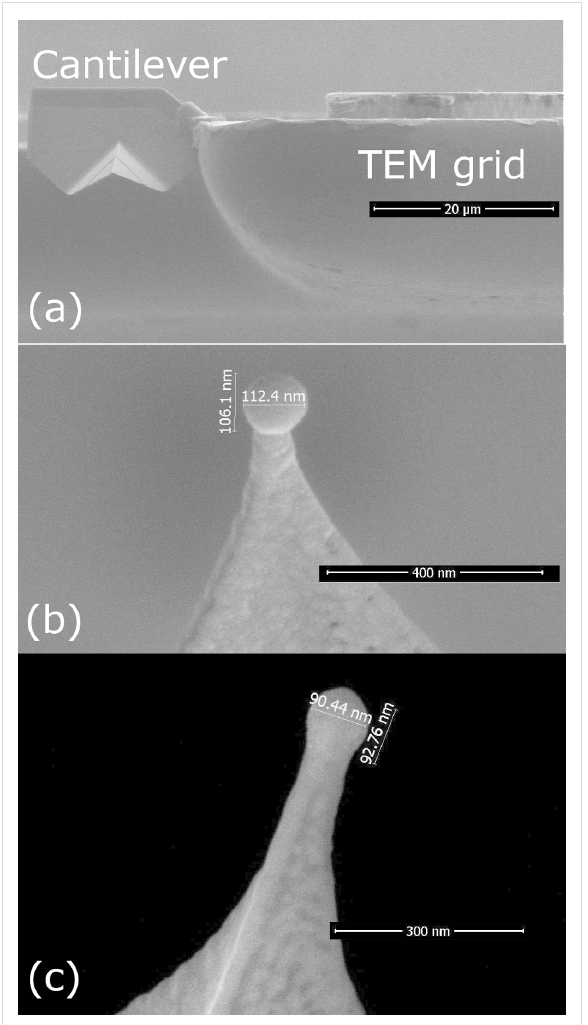
Figure 3: SEM micrographs of the cobalt nanospheres grown on canti- lever tips for STEM-EELS and electron holography experiments. (a) Cantilever pyramid tip welded to a TEM grid. (b,c) Cobalt nano- spheres grown by FEBID on the apex of the cantilever already at- tached to the TEM grid. The diameter of the nanospheres shown is 110 nm (b) and 90 nm